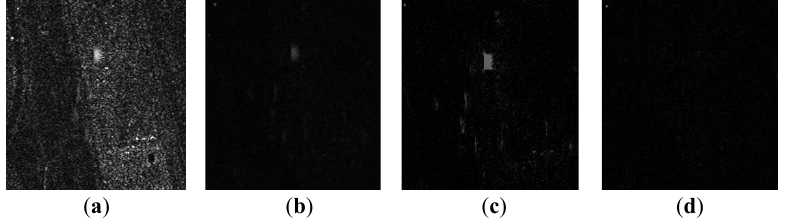
Figure 17. Comparisons of the algorithms in dealing with the azimuth ambiguities, ( a ) the azimuth ambiguities caused by the side lobes of the antenna pattern, ( b – d ) the processing result of the azimuth ambiguities by the DPCA, the Deramp-STAP, and the multilayer